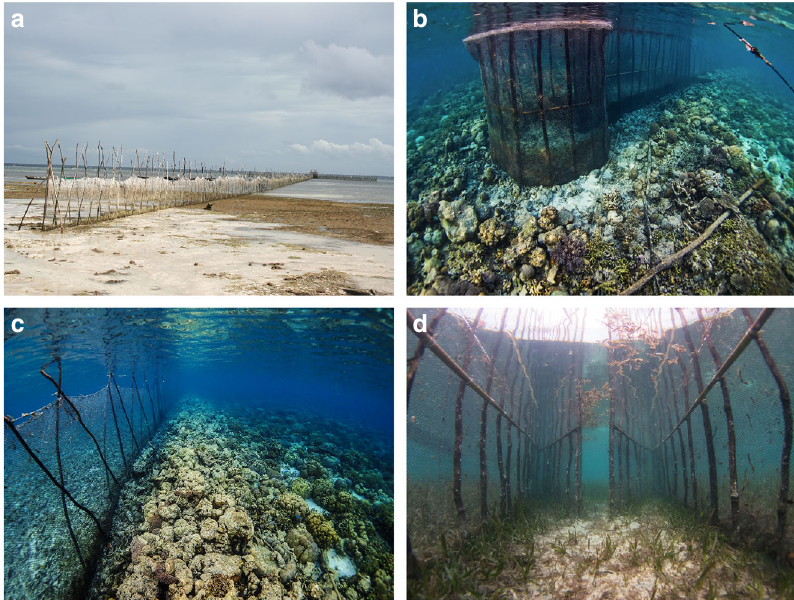
Fig. 1 Indonesian fi sh fences on intertidal reef fl ats, showing a an 80 m long fence at low tide, b a halo of benthic habitat loss caused by direct clearance and/or the use of poison, c a fence acting as an arti fi cial barrier preventing a healthy benthic community from persisting on the landward side and d cleared seagrass within the fence structure. Photo credits: Benjamin Jones, Project